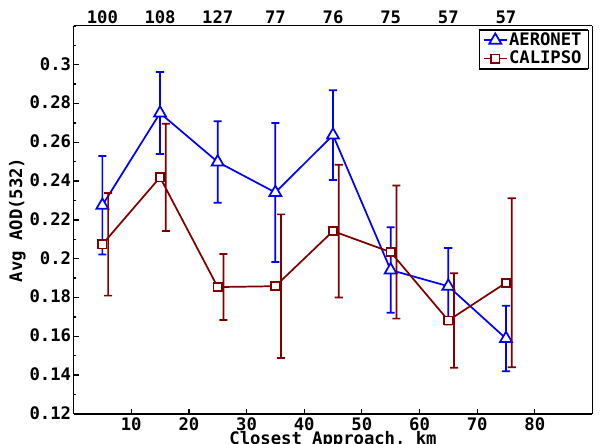
Fig. 2. Correlation coefficients for the optical depths of Fig. 1 (black circles) and the autocorrelations of aerosol plumes measured by An- derson et al. (2003). Correlations that are significantly less than the Anderson et al. (2003) values indicate that other factors are more important than spatial separation.